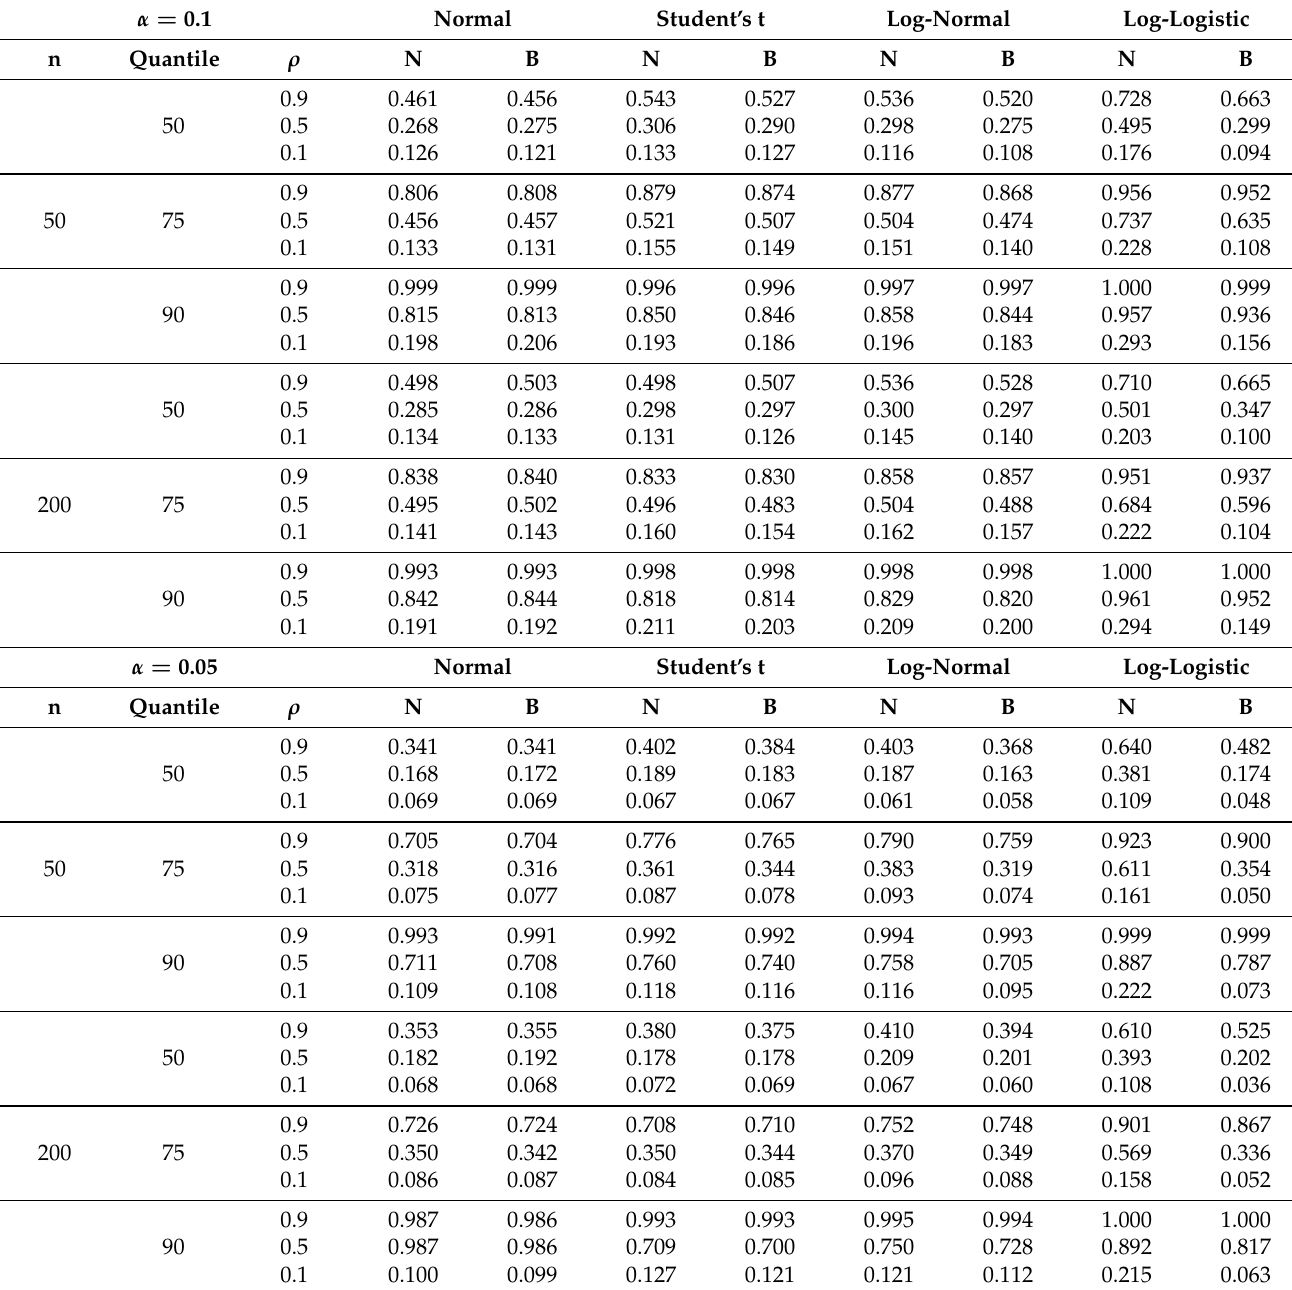
Table 1. Simulation results for global Moran’s I statistic using asymptotic inference (N) and bootstrap inference (B), both at 5% significance